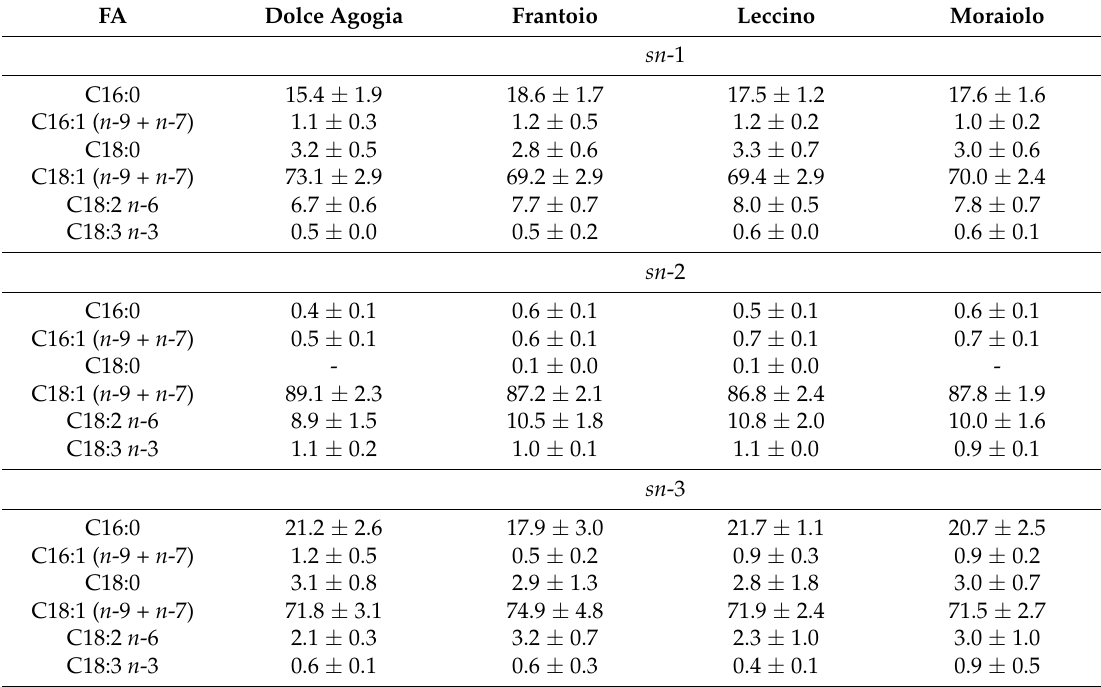
Table 2. Intrapositional FA percent composition of TAG fraction of monovarietal EVOO samples (% mol, mean values ± SD, n = 3). FA Dolce Agogia Frantoio Leccino Moraiolo sn